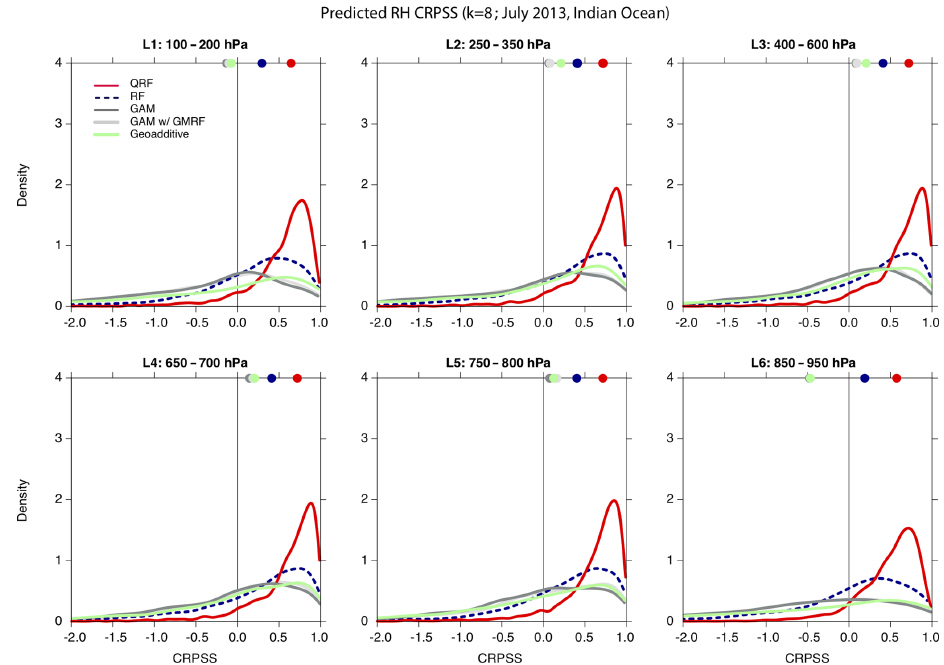
Figure 4. CRPSS for ice cloud profiles ( k = 8) in the Indian Ocean, July 2013: QRF (red solid line), RF (blue dashed line), GAM (dark grey solid line), and GAM with GMRF smoother (light grey solid line) and with the geoadditive method (green solid line). The dots at the top of each panel indicate the median of the distribution. Predictions are from the validation set within a 5-fold cross-validation scheme.